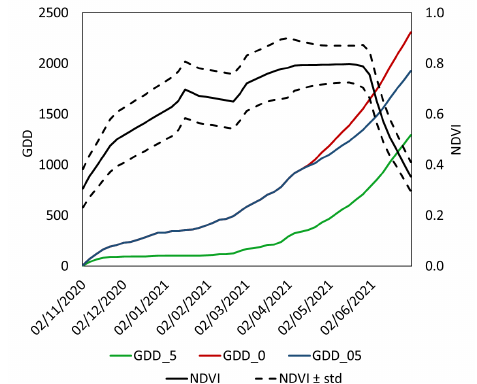
Figure 6 . GDD profiles (GDD_5, GDD_0, GDD_05) as computed with reference to the three considered T BASE values. NDVI and GDD profiles are the average ones from the whole WW dataset.